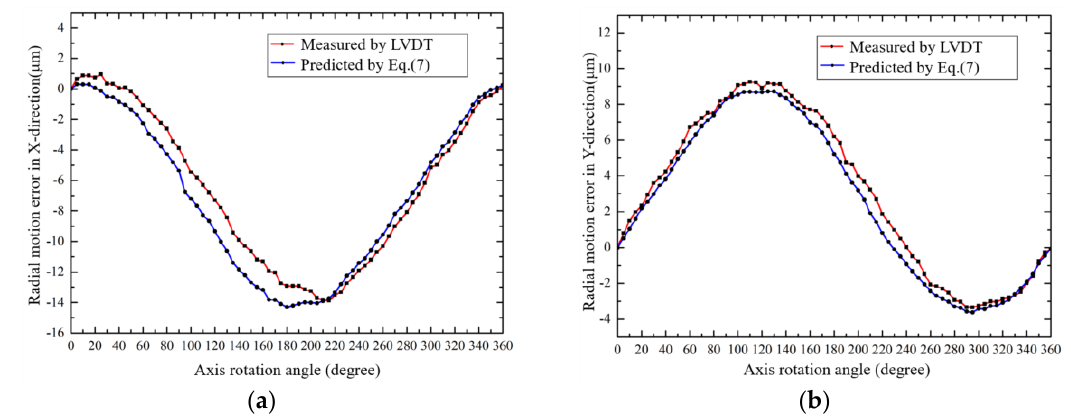
Figure 14. The radial error motion of the axis ( h = 60 mm): ( a ) X-direction; ( b ) Y-direction.